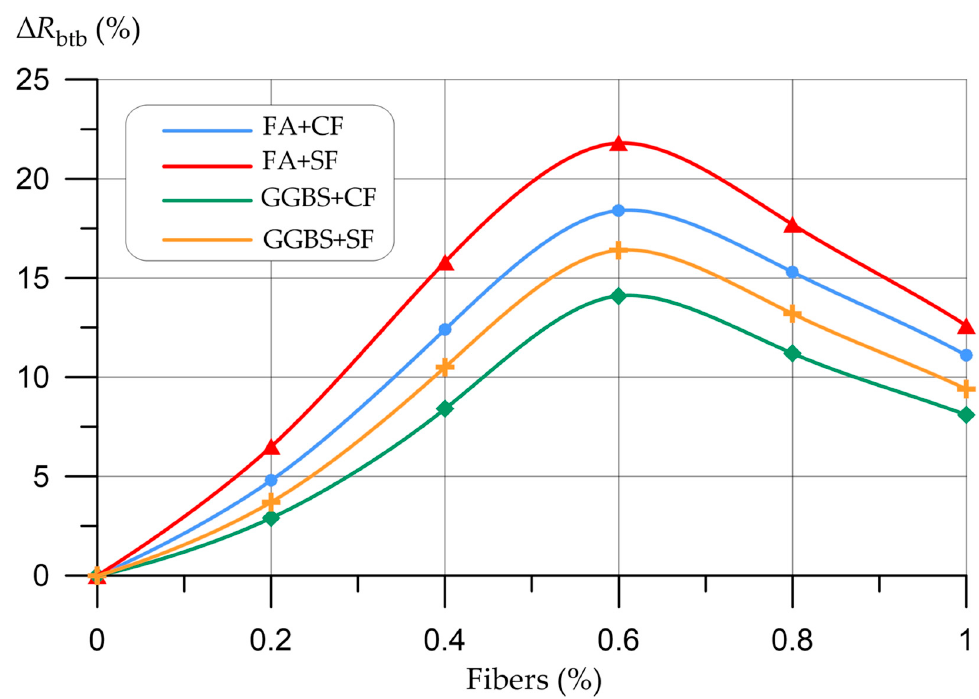
Figure 13. BS trend of modified non-autoclaved aerated concrete with different fiber content (FA + CF—aerated concrete modified with FA and reinforced with CF; GGBS + CF—aerated concrete modified with GGBS and reinforced with CF; FA + SF—aerated concrete modified with FA and reinforced with SF; and GGBS + SF—aerated concrete modified with GGBS and reinforced with SF). As in the case of CS, the maximum BS gains are observed in aerated concrete modi- fied with FA and reinforced with SF. The BS trend is similar to the CS trend. Peak values of BS increments are observed at a fiber dosage of 0.6%; at dosages of 0.2% and 0.4%, a positive trend of BS growth is observed; and at dosages of 0.8% and 1.0% fiber, a negative trend of a decrease in strength is observed. For FA-modified and CF-reinforced aerated concrete, the BS gain was 18.4%; and for FA-modified and SF-reinforced aerated concrete, the BS gain was 21.8%. GGBS-modified CF-reinforced aerated concrete had a maximum BS gain of 14.1%, and SF-reinforced aerated concrete had a maximum BS gain of 16.4%. As with CS, SF aerated concrete has a higher BS than CF aerated concrete. This can be explained by the fact that sisal fibers have superior mechanical properties compared to CF and this is reflected in samples of aerated concrete reinforced with corresponding fi- bers. As is known, the mechanical characteristics of concrete depend on the mechanical properties of the fiber and matrix (concrete) and the amount of fiber. If fiber is added in excess of the obtained rational effective dosage, the tendency to decrease in strength may be due to the uneven orientation of the fibers and the presence of voids due to the higher fiber content. Additionally, an increase in the fiber dosage in excess of the optimal amount leads to a violation of the rheological properties of the mixture due to the resulting greater water demand of the mixture, which leads to a drop in strength [39]. Figure 14 below shows the CCQ values of FA-modified and GGBS-modified aerated concrete with different CF and SF dosages.